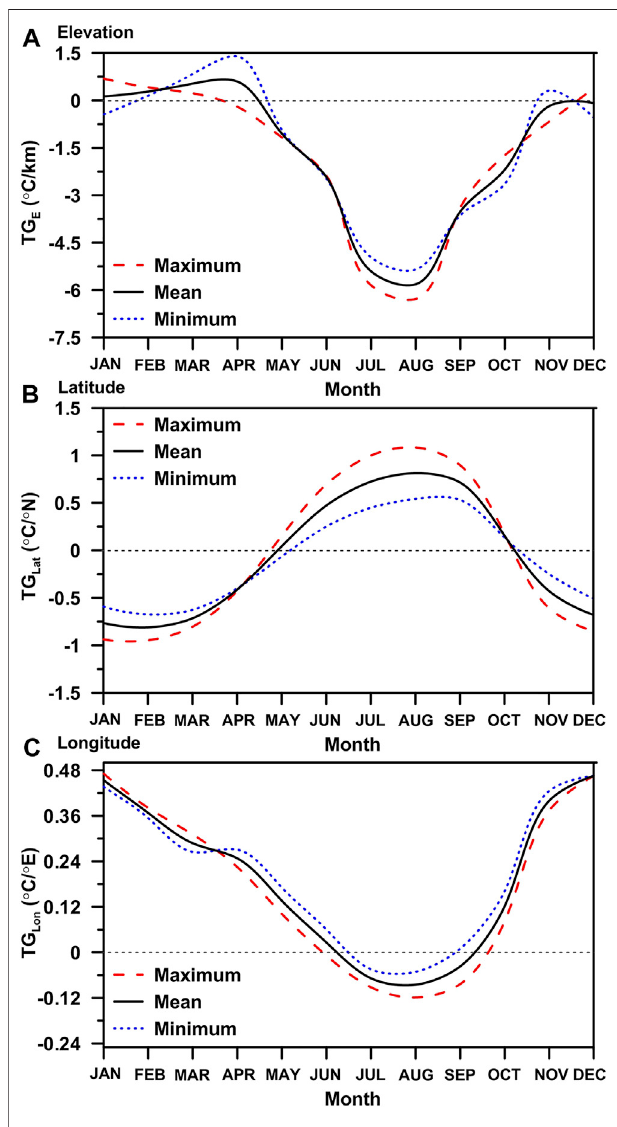
FIGURE 5 | Annual cycle of temperature gradient with elevation (A) , latitude (B) , and longitude (C) over the study region.